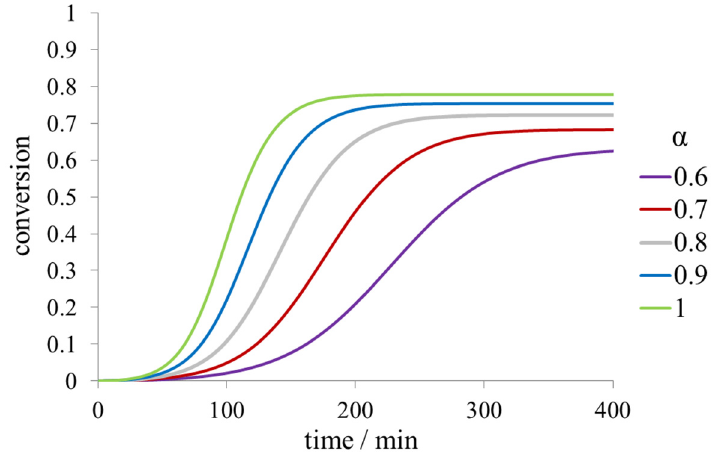
Figure 7. Dependence of the time course on the fraction of aggregation-capable protein form ( α ) for the model of reversible fibril formation with secondary nucleation and